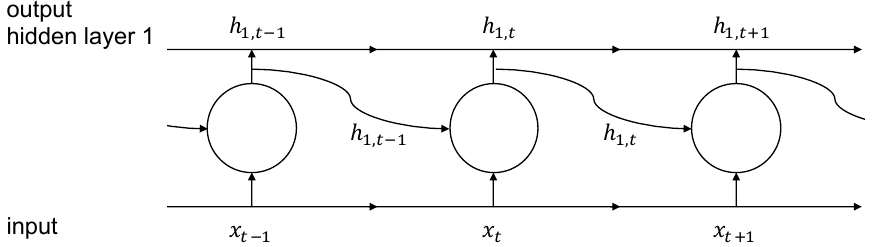
Figure 1. Schematic representation of an unfolded RNN unit. Adapted from